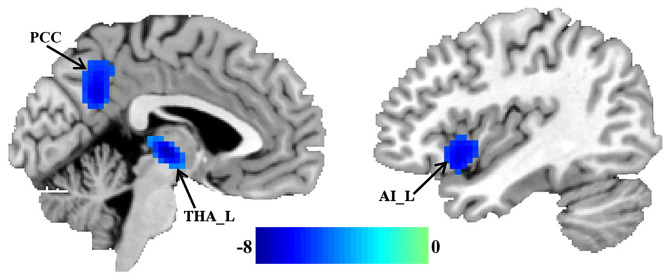
Decreased whole brain functional connectivity pattern homogeneity (FcHo) in patients with migraine without aura. Two-sample t-test was used to compare the FcHo maps between healthy controls and patients with migraine without aura and identified significantly decreased FcHo in the posterior cingulate cortex (PCC), thalamus (THA), and left anterior insula (AI) in patients with migraine without aura.